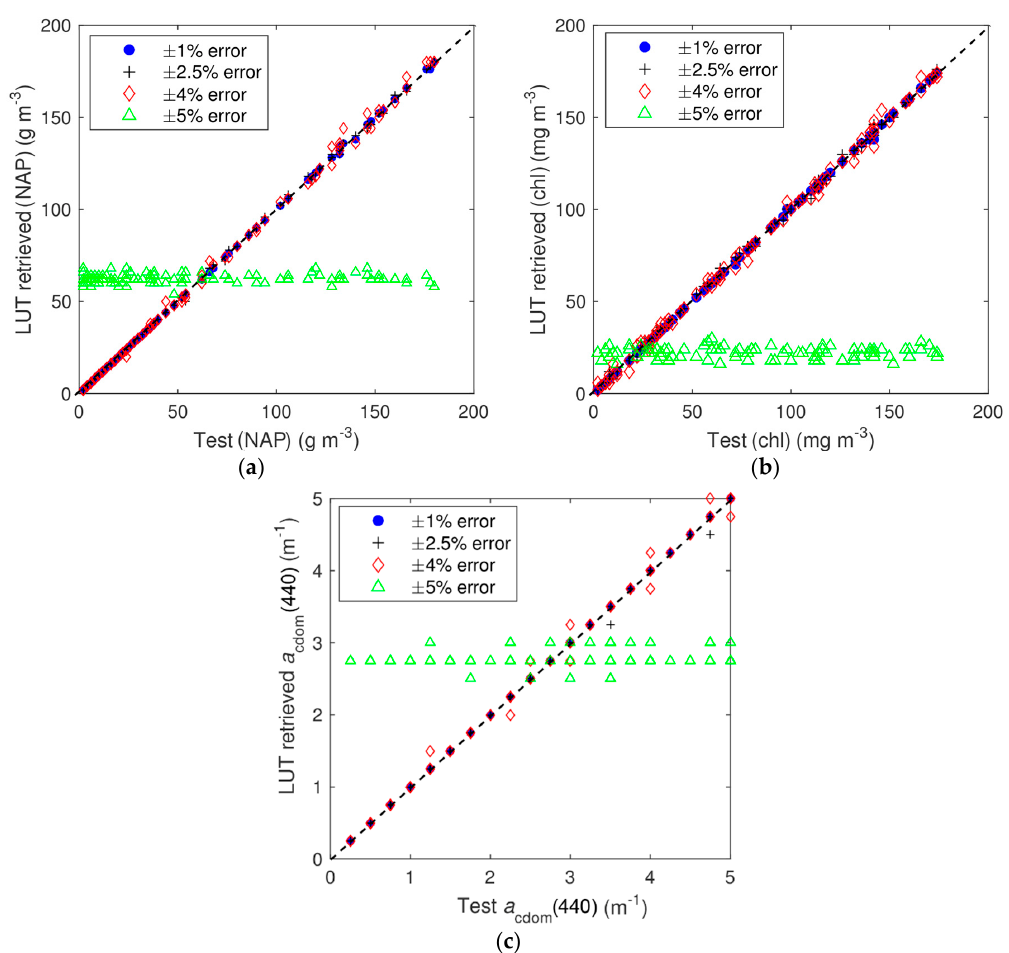
Figure 12. Comparison between test and look-up table estimated concentrations of: ( a ) non-algal particles ((NAP)); ( b ) chlorophyll ((chl)); and ( c ) colored organic matter ( a cdom (440)), for the Wabash River and the Tippecanoe River. The dotted line represents 1:1 line.